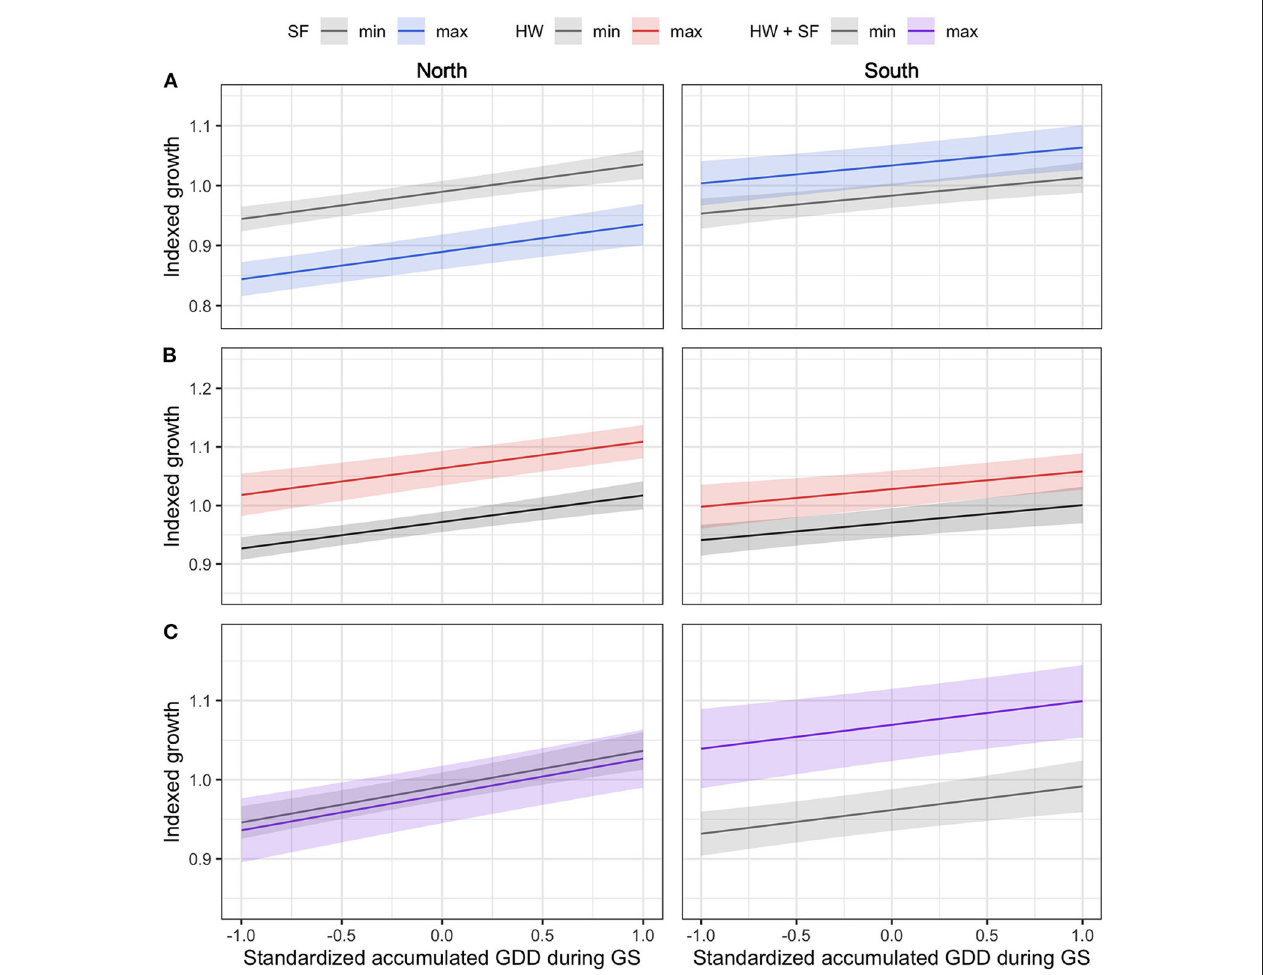
FIGURE 3 | The effect size of acute events relative to the effect size of standardized GDD accumulated during the growing season (GS). The effect sizes were quantified by calculating the mean predicted growth across the observed range of accumulated GDD during GS, as modified by the occurrence of minimum- and maximum-intensity events observed in each region, including spring frosts [SF; (A) ], heat waves [HW; (B) ], and a combination thereof [SF + HW; (C) ]. Confidence intervals of the predictions (shaded area) were calculated with α = 0.05.